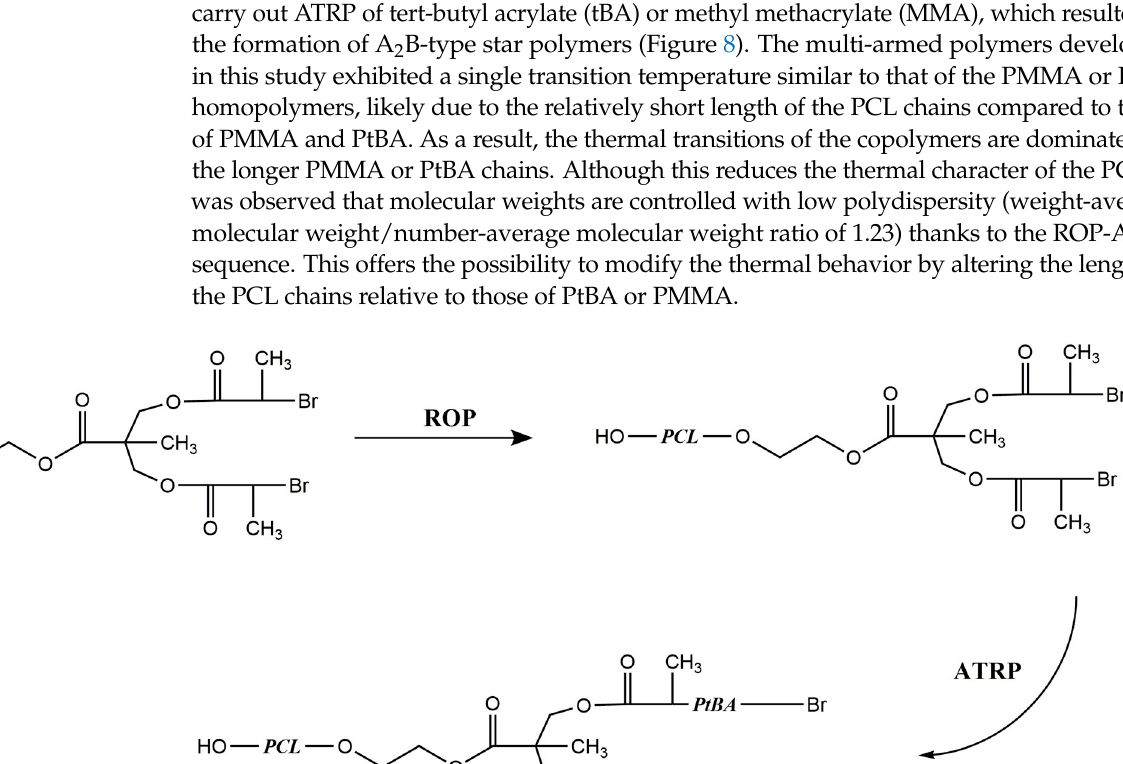
Figure 7. Synthesis of multiarms (PCL-PGMA) through the ROP and ATRP.